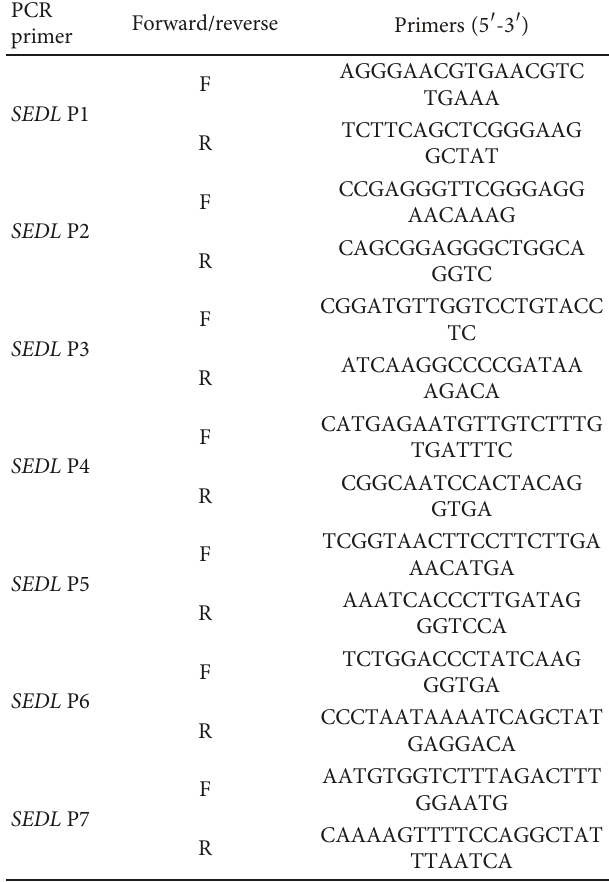
Table 1: PCR primer sequences of the SEDL gene.